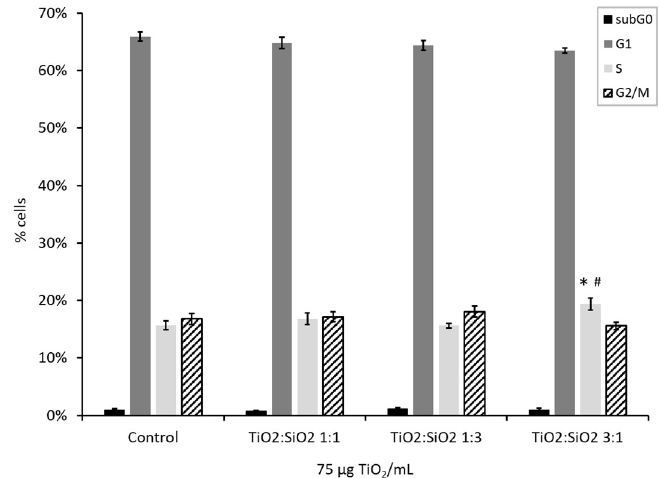
Figure 6. Different phases of the cell cycle (subG0, G1, S, and G2/M) were evaluated through Propidium Iodide content by cytofluorimetric analysis. The histograms represent the mean ± SE of at least three independent experiments. * Statistically significant with respect to control sample; # Statistically significant with respect to the sample TiO 2 :SiO 2 1:3. Unpaired t -test, p < 0.05.